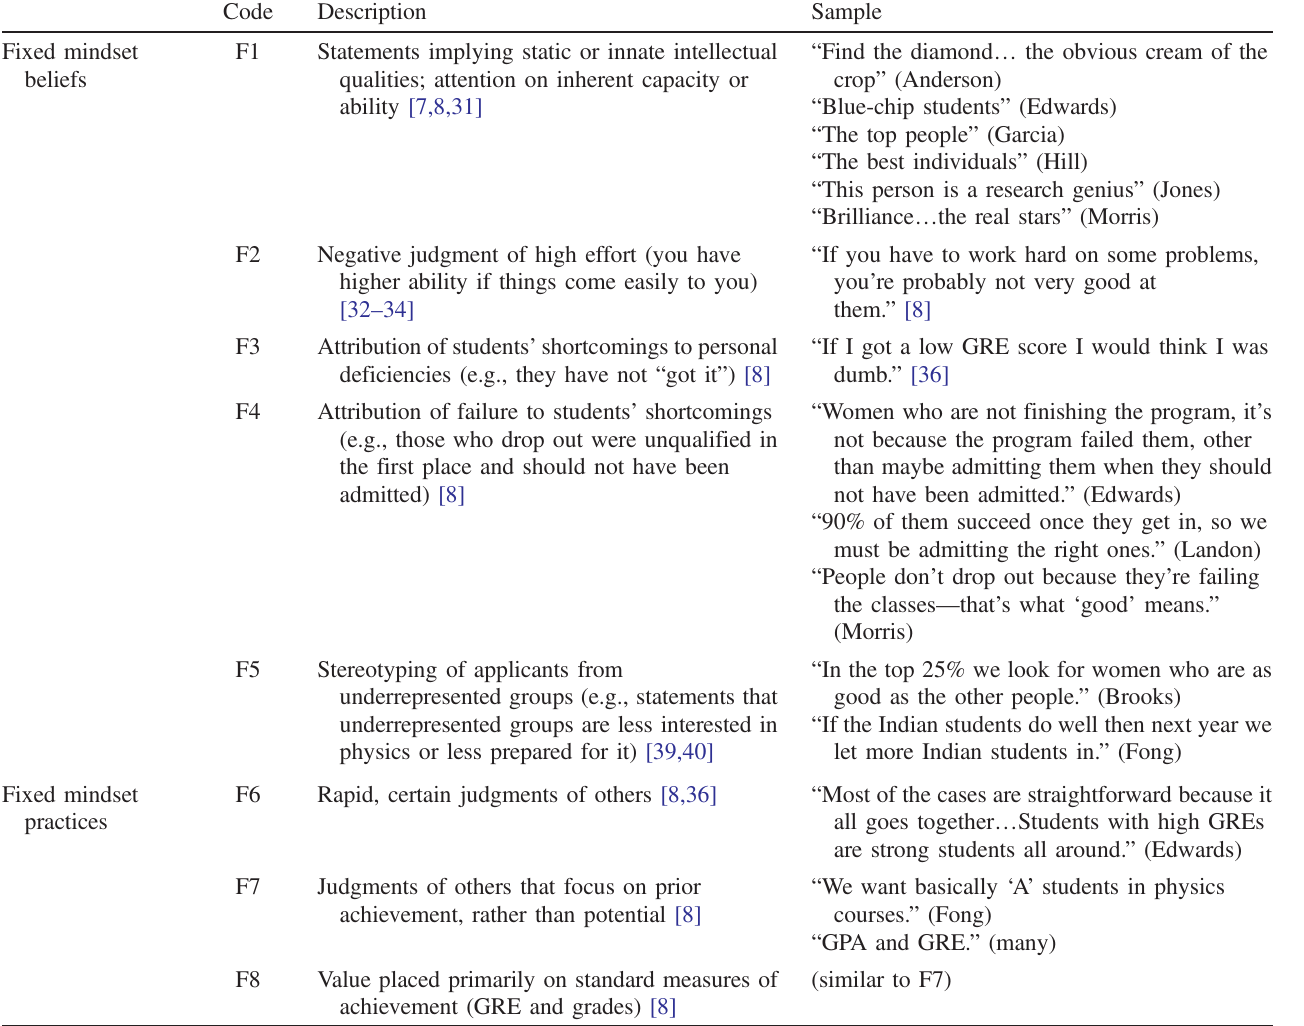
TABLE I. Coding scheme for fixed mindset (F1 – F8), with sample text from interviews to illustrate each code. Codes F1 – F5 refer to beliefs or attitudes associated with the fixed mindset; codes F6 – F8 refer to practices associated with that mindset. Names are pseudonyms of individual